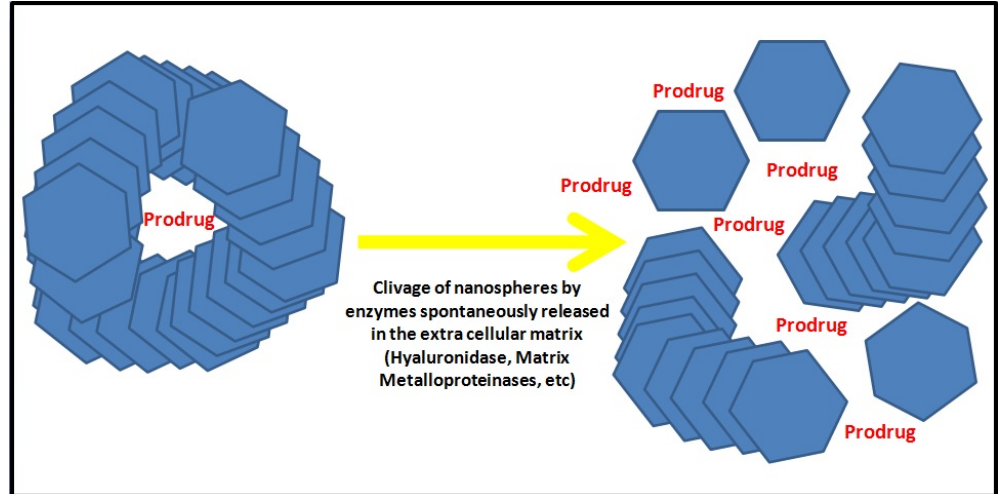
Figure 2. Protease ‐ activated drug delivery. Following identification of their targets, the release of a prodrug encapsulated in theranostic agents, based for instance on nanospheres of hyaluronic acid or quantum dot gelatin nanoparticles, is obtained through cleavage of their scaffold by enzymes highly expressed in tumors (such as hyaluronidase or matrix metalloproteinase 2).